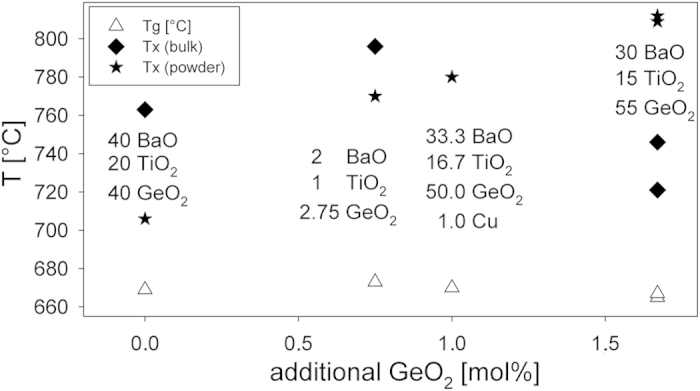
Tg and Tx values of the glass compositions in Table 1 only modified in the amount of added GeO2 as well as the composition 1 Cu-33.3 BaO-16.7 TiO2-50 GeO2.